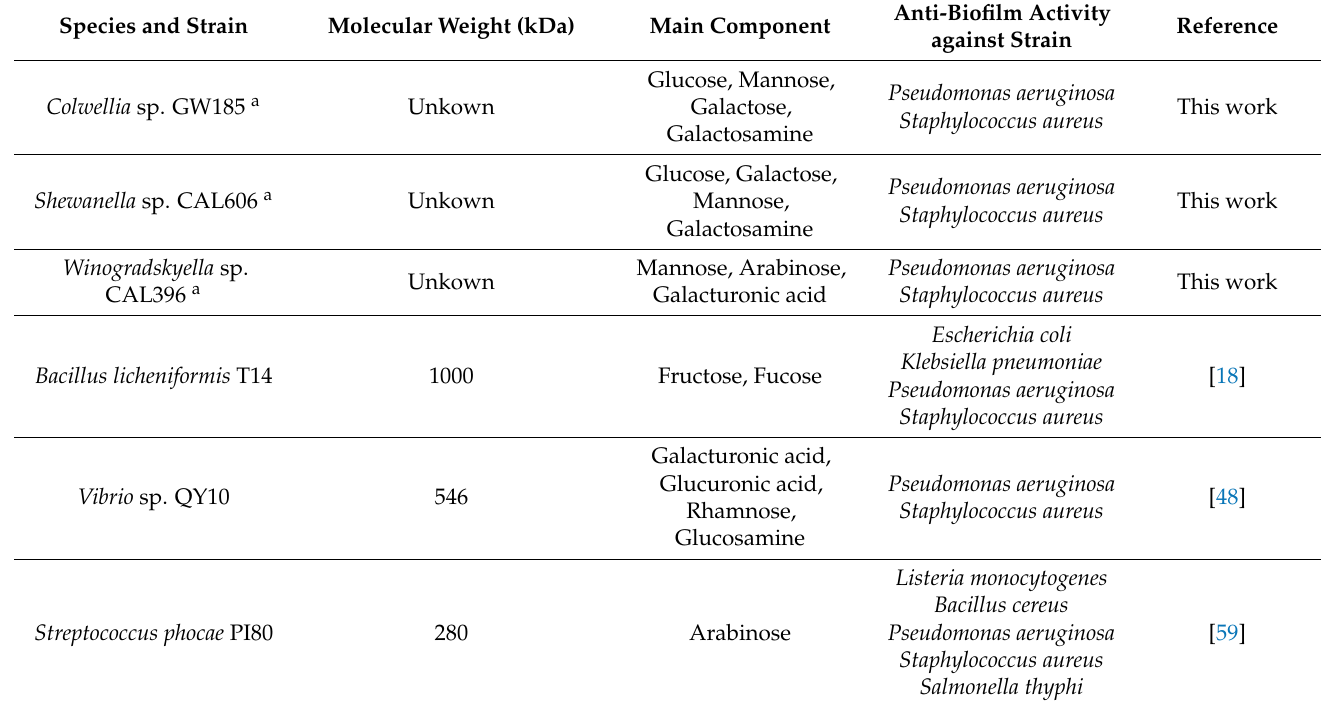
Table 6. Bacterial exopolysaccharides with antibiofilm activity against pathogenic bacteria ( a Caruso et al. [26]). Species and